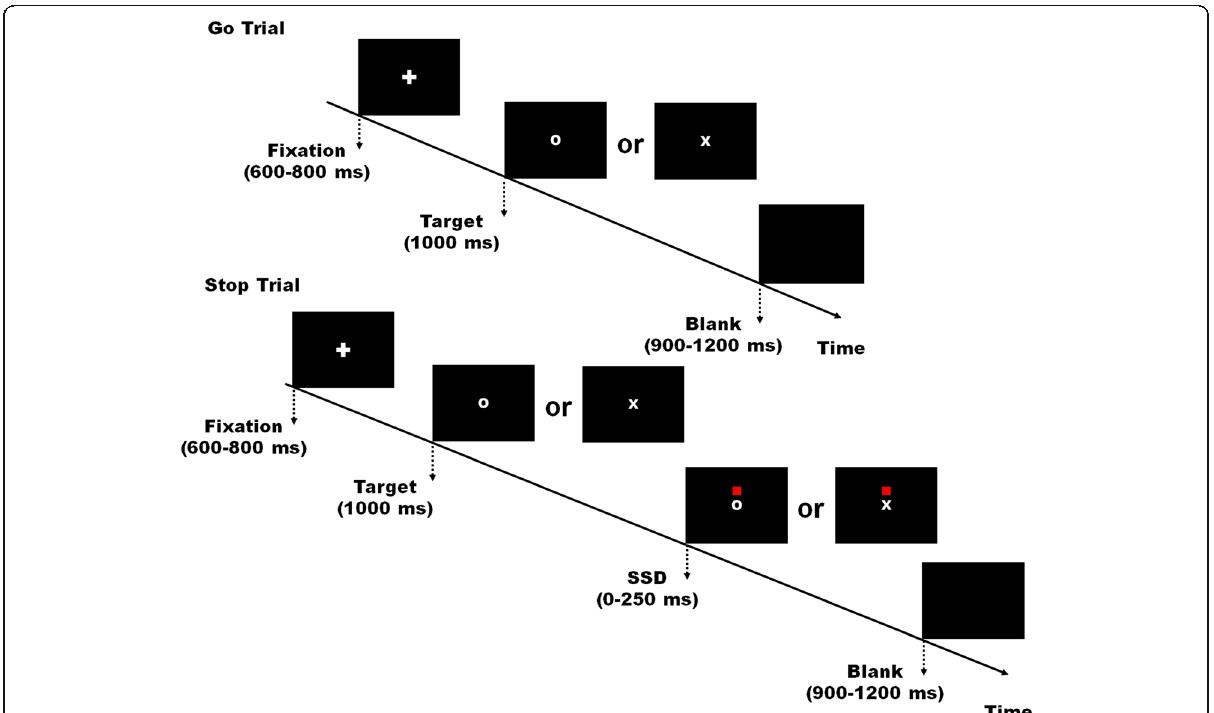
Fig. 1 Stop signal paradigm. This task included 80% Go trials and 20% Stop trials. On Go trials, participants were presented with a fixation cross on a black computer screen lasting for 600 – 800 ms, which is immediately followed by a Go stimulus (the letter ‘ X ’ or ‘ O ’ ) (a Go signal) lasting for 1000 ms. Participants were instructed to judge the shape of the Go stimulus as accurately and quickly as possible via a button press with the index fingers of the left and right hands. On the remaining Stop trials (20%), the stop stimulus (a red square appearing above the location of the go stimulus) appeared after the Go stimulus after a variable delay of 0 – 250 ms in a step of 50 ms (the stop signal delay; SSD), cuing participants to withhold their responses to the Go stimulus. A variable intertrial interval was 1500 – 2000